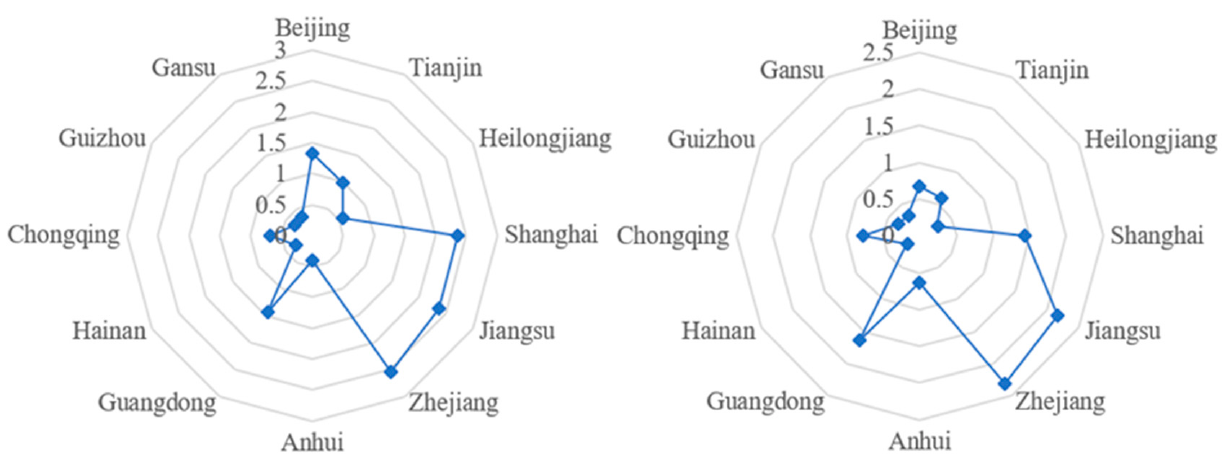
Figure 4. The trends of MAGG during the years 2010–2019.